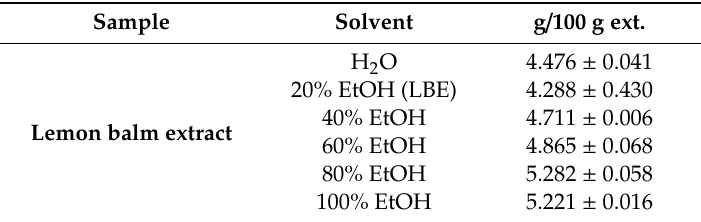
Table 1. Di ff erence of RA content between solvents. Table 1. Difference of RA content between solvents.